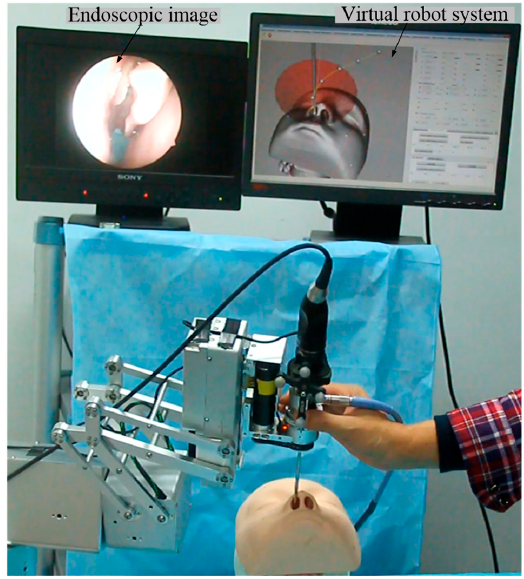
Figure 15. Surgical scene of the interactive endoscopic nasal examination.